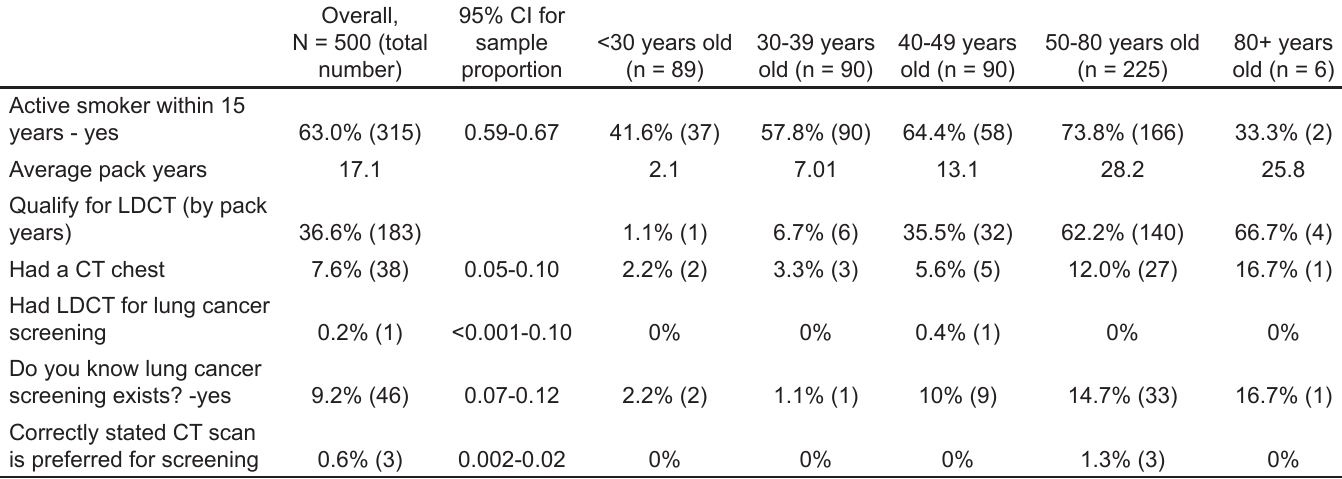
Table 2. Outcomes data for lung cancer